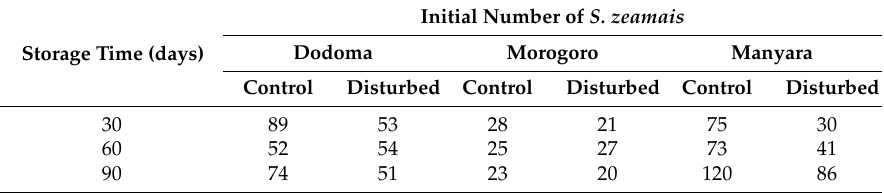
Table 2. Initial numbers of S. zeamais in each region per 0.5 kg of infested